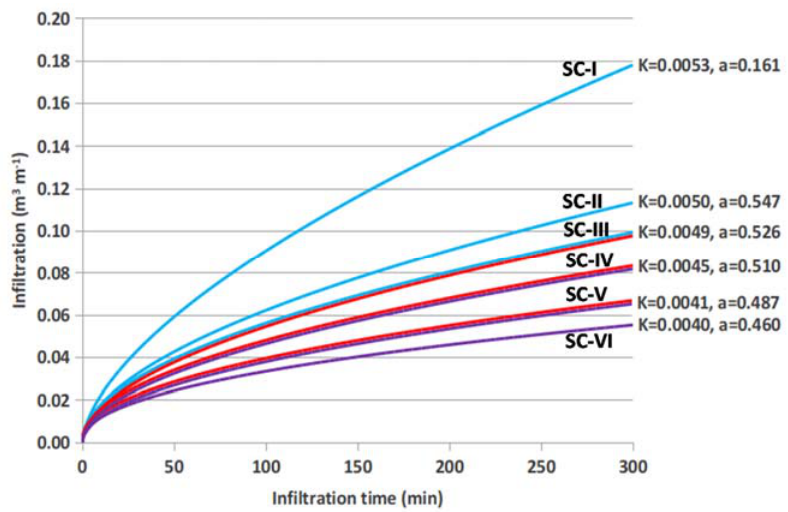
Figure 3. Cumulative infiltration curves SC ‐ I to SC ‐ VI characterizing the infiltration families relative to high, medium, and low infiltration rates represented with blue, red, and violet lines, respectively.